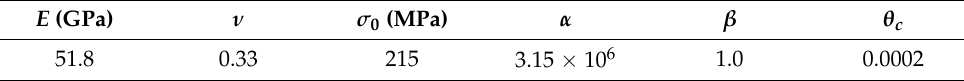
Stress ‐ strain curve (Yang ʹ s model) Stress ‐ strain curve (proposed model) Damage ‐ strain curve (Yang ʹ s model) Damage ‐ strain curve (proposed model)